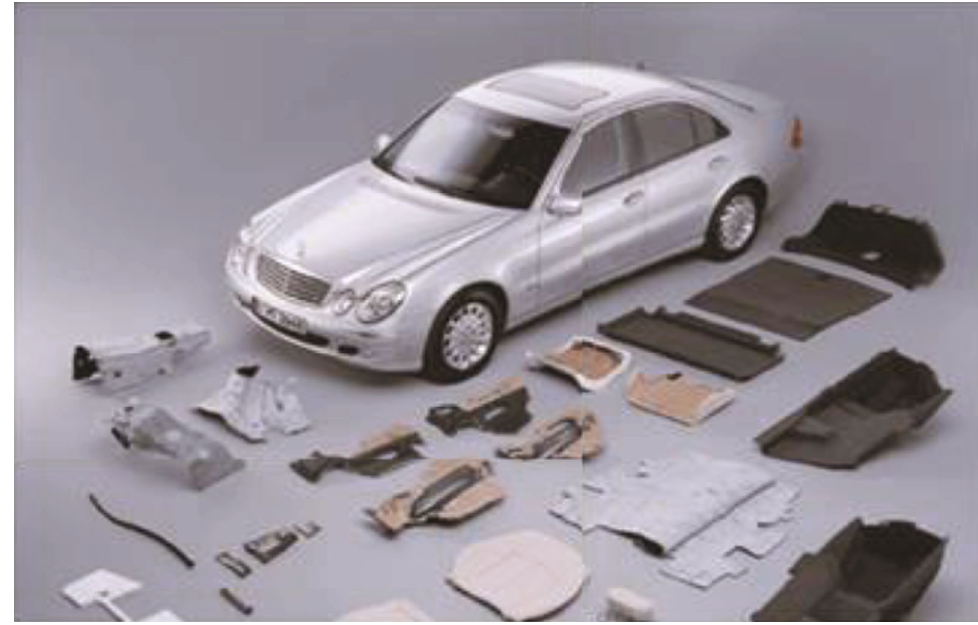
Figure 1: A vehicle showing numerous parts produced from PMCs [36]. Table 1: Automakers and parts produced from polymer matrix composites [36].